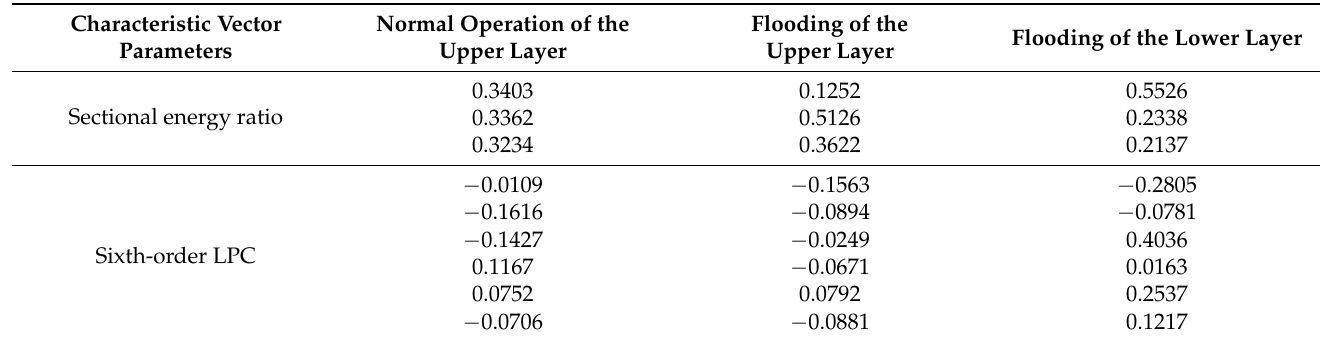
Table 2. The characteristic vector parameters of acoustic signal of tray column under different operating conditions.